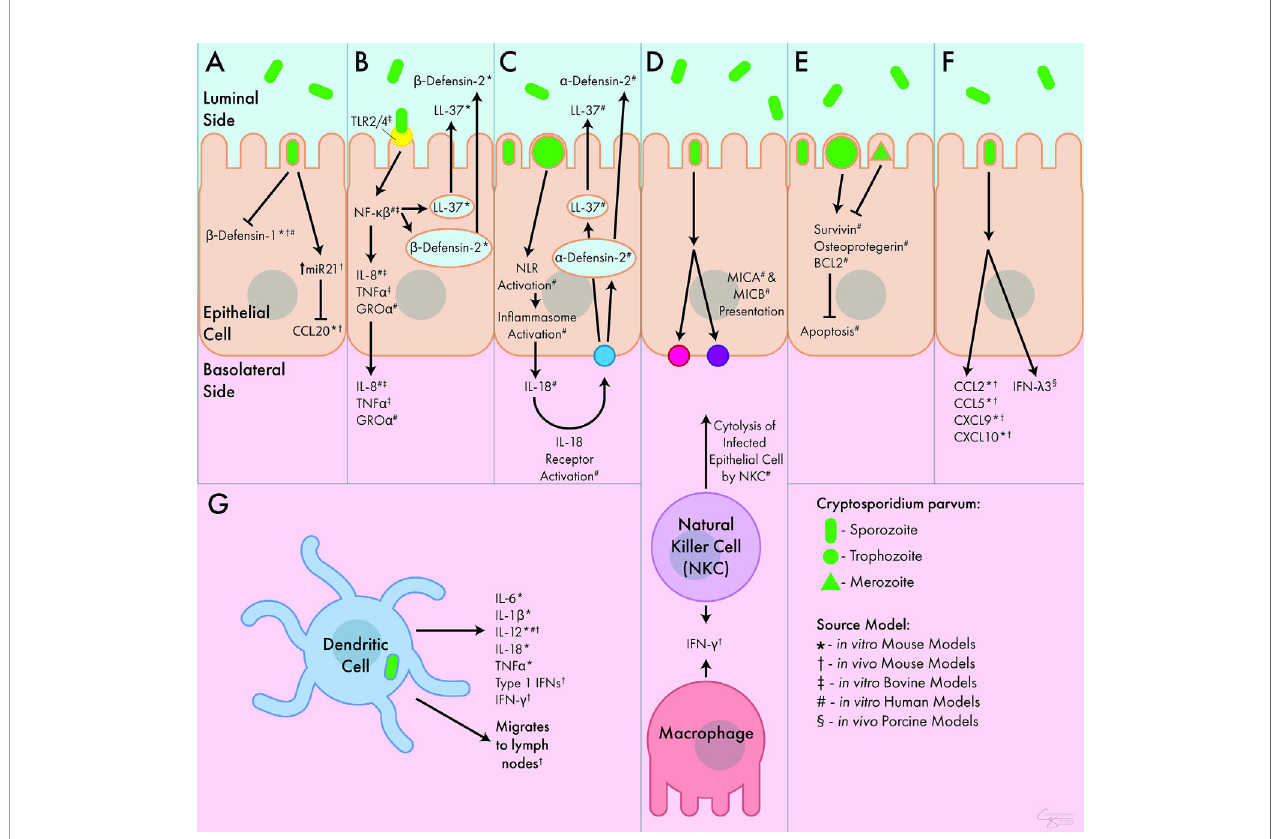
FIGURE 1 | Innate Immune Response to C. parvum . (A) C. parvum inhibits the release of the antimicrobial peptides b -defensin-1 and CCL20. (B) Activation of TLR receptors by C. parvum leads to the luminal secretion of antimicrobial peptides b -defensin-2 and LL-37 as well as the basolateral secretion of IL-8, TNF a , and GRO a . (C) In fl ammasome activation by C. parvum leads to the basolateral release of IL-18, which causes the luminal secretion of a -defensin-2 and LL-37. (D) C. parvum -mediated presentation of MICA and MICB lead to cytolysis of infected epithelial cells by NK cells. NK cells and macrophages both act as sources of IFN- g during infection. (E) C. parvum trophozoites stimulate apoptosis, but merozoites inhibit apoptosis, mediated through survivin, osteoprotegerin, and BCL2. (F) In response to C. parvum , intestinal epithelial cells release numerous chemokines and cytokines including CCL2, CCL5, CXCL9, CXCL10, and IFN- l 3. (G) DCs respond to C. parvum by releasing IL-6, IL-1 b , IL-12, IL-18, TNF a , and type I interferons. They can also migrate to lymph nodes following parasite exposure. Interferon (IFN), Interleukin (IL-), Tumor Necrosis Factor (TNF), C-C Chemokine Ligand (CCL), C-X-C Chemokine Ligand (CXCL), Growth Regulated Oncogene (GRO), Toll-Like Receptor (TLR), Nod-Like Receptor (NLR), MicroRNA 21 (miR21), Nuclear Factor (NF), Cathelicidin (LL-37), Major Histocompatibility Complex Class I Chain-Related Protein (MIC), B-Cell Lymphoma 2-Apoptosis Regulator (BCL2), Natural Killer Cell